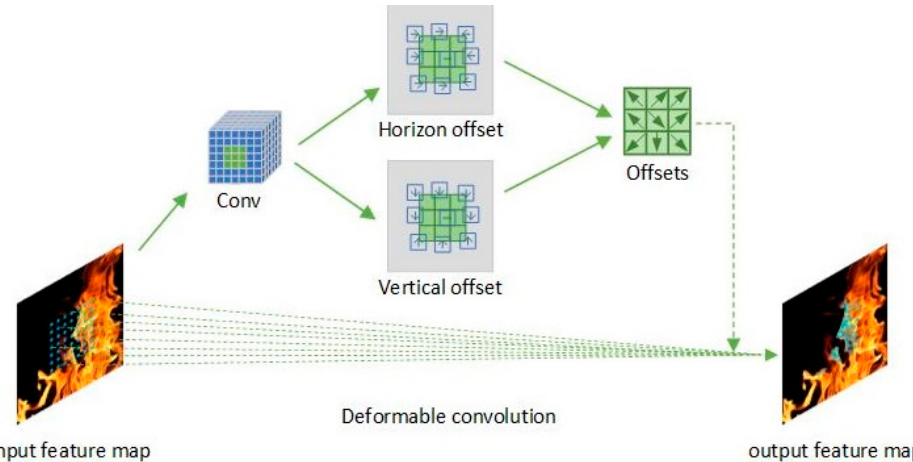
Figure 3. Schematic diagram of the joined deformable convolutional network.